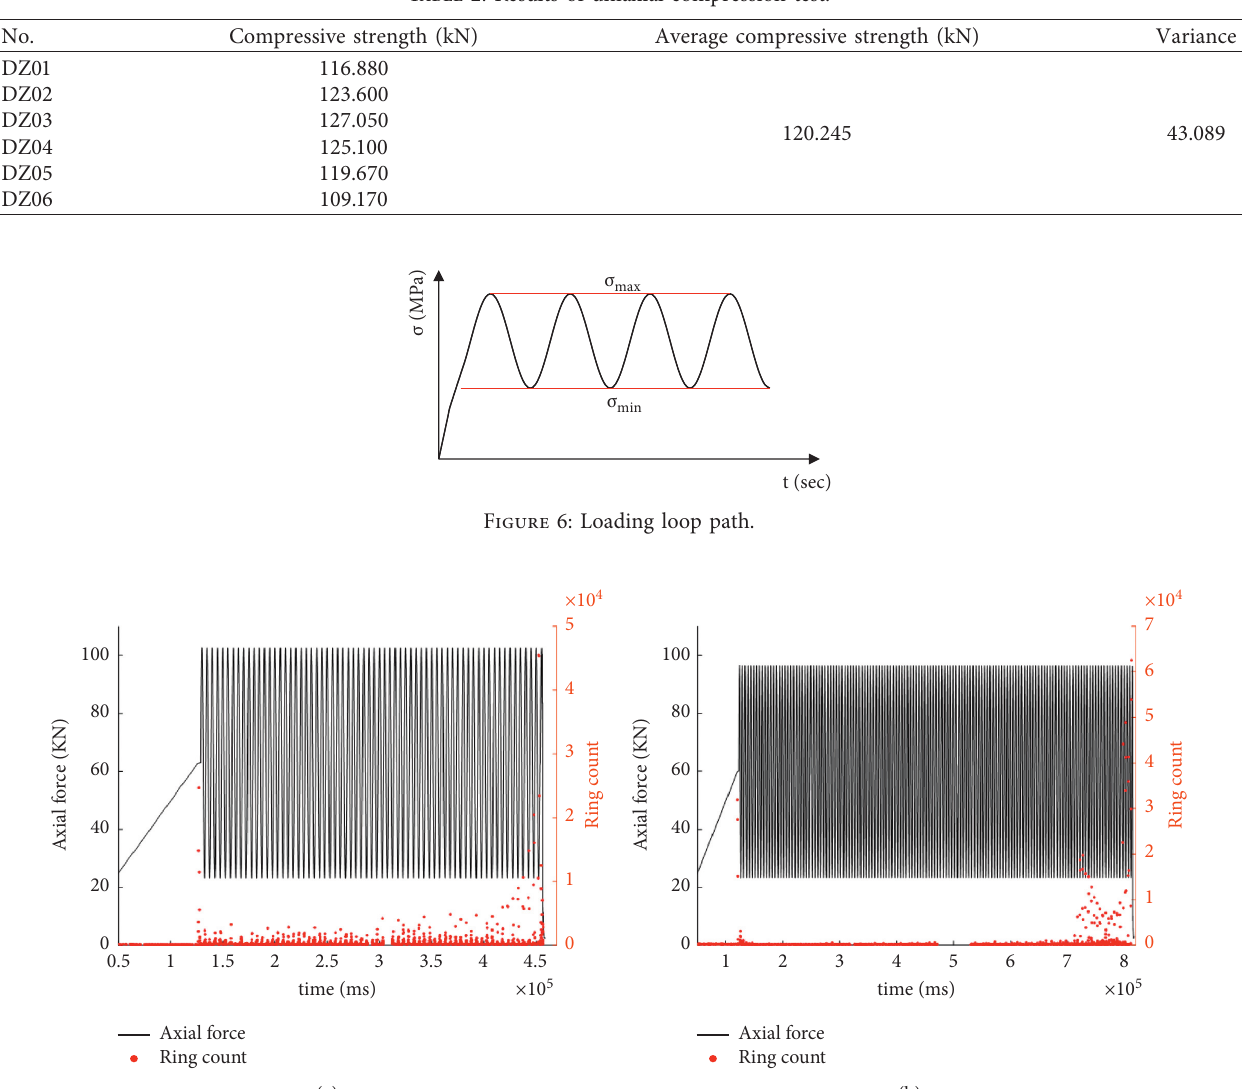
Table 2: Results of uniaxial compression test.